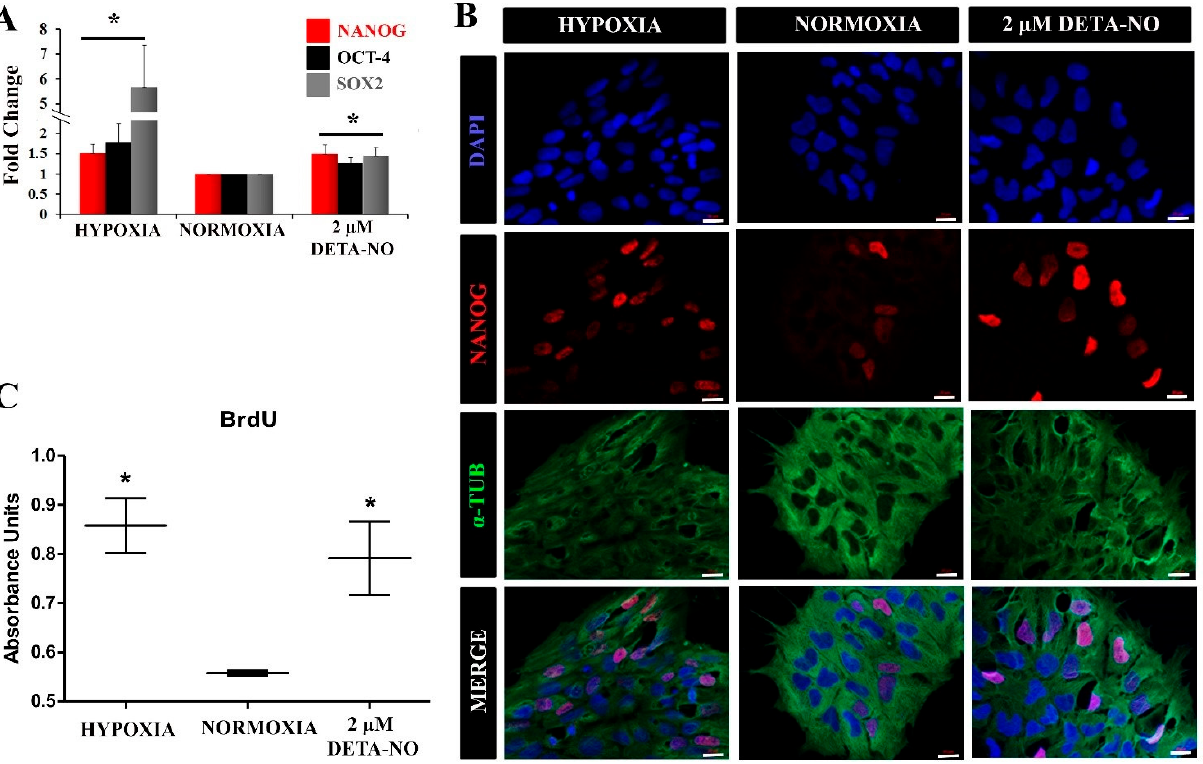
Figure 3. Exposure to low doses of DETA-NO increases the expression of pluripotency markers and improves cell prolif- eration. ( A ) Analysis of the expression of NANOG and OCT-4 by qPCR. The plot shows the mean of the relative expression of 5 independent experiments ± SEM. The relative expression of these genes has been obtained using the algorithm ∆∆ Ct. β -actin expression is used as a housekeeping gene and data were relativized to the expression in normoxia. (*) p < 0.05. ( B ) Exposure to low doses of DETA-NO increases the expression of NANOG with nuclear localization. After 6 days of culture under normoxia, MSUH-001 cells were exposed to hypoxia (5% of O 2 ) for 4 days and to low NO treatment for 48 h. NANOG-positive cells were visualized by fluorescence microscopy. Cells were labeled with DAPI (blue), anti-NANOG (red), and anti- α -Tubulin (green). The images shown are representative of more than 12 planes per experimental condition of 2 independent experiments, and they have been acquired with the Zeiss ApoTome fluorescence microscope. Scale bar: 25 µm. ( C ) Cell proliferation measurement by BrdU incorporation. The graph represents the median with individual data points of 2 independent experiments with at least 4 replicates for each experimental condition. (*) p < 0.05. 3.2. NO Treatment in Normoxia Shifts the Metabolic Profile of Human PSCs towards Glycolysis To assess the effect of NO on cellular metabolic profile, the expression of genes in- volved in the hypoxia response was analyzed. Hexokinase 2 (HK-2), lactate dehydrogen- ase A (LDH-A), and pyruvate dehydrogenase kinase 1 (PDK1) mRNA were increased in cells treated with NO and in cells cultured in hypoxia for 48 h compared to normoxia control (Figure 4A). The increase induced by nitric oxide treatment was statistically sig- nificant, although much lower than that induced by hypoxia. Next, we studied the effect of NO on the expression of pyruvate kinase muscle isozyme M2 (PKM2) gene. The results show that treatment with DMOG, an inhibitor of prolyl hydroxylase (PHD) activity, in- creases the level of PKM2 gene expression under normoxia conditions as does treatment with 2 µM DETA-NO and hypoxia (5% O 2 ) (Figure 4B). Furthermore, the mRNA expres- sion of VEGF-A, a target gene of HIF-1 α , is also increased under the tested experimental conditions. (Figure 4C).